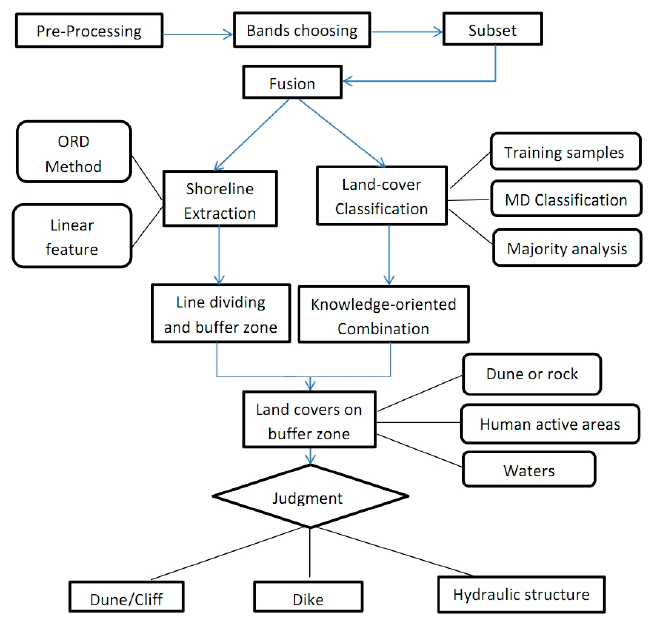
Figure 3. Ecological knowledge-oriented reclassification and estimation of shoreline structure.